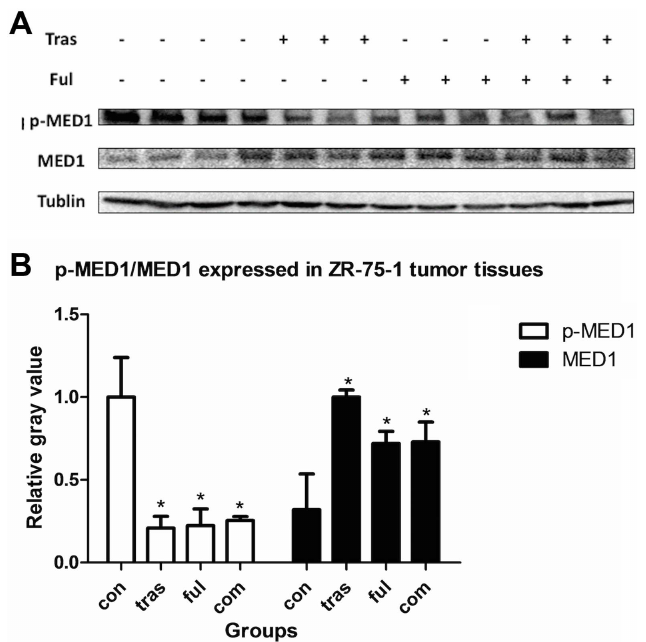
Fig 9. Immunoblot analysis of the levels of the proteins p-MED1 and MED1 expressedin ZR-75-1 tumor xenografts. Three samplesfrom each group were randomly selected. Similar results were obtained after two experimental repeats. Thus, representative bandsfrom a singleexperimentare shownhere. Trastuzumab and fulvestrant either as singleagents or in combination decreased levels of the protein p- MED1 ( P < 0.05)and increasedlevels of MED1 total protein ( P < 0.05).However, no significantdifferences were observed betweencombination groupsand individuallytreated groups ( P >